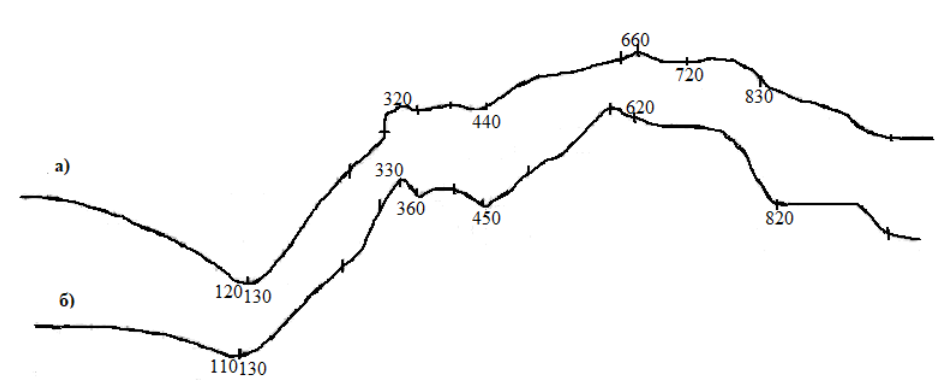
Fig. 7. Derivation of soil-concrete consistencies : a) experimental and b) control soil- concrete samples (DThA) (consistence 2) . To study the effect of heat treatment using solar energy on the hardening of soil concretes on the basis of oil - contaminated soil, cement, and sand , 2 series of consistence using concrete additives have been formed. Under the code 22, samples were formed, hardening in natural conditions. Under the code 2, the consistence s subjected to heat treatment with the use of solar energy are indicated (Fig . 7). To study the effect of heat treatment with the use of solar energy in the mineralogical consistence of the soil - concrete were moulded for samples consisting of sludge, cement, and sand. The control sample under code 44 hardened in vivo, as an experimental model under code 4 is heat treated using solar energy. According to the thermal analysis results can be seen that the DThA – endoeffect curve ( – ) 100 ° С removal of free water. Exoeffects (+) and 320 (+) 410 °C burning hydrocarbon components of the sludge. Exoeffects (+) 2 20 ° С – consistence of hydrocarbons and methane series (+) 320 ° С – waxy structure of the organic components of sludge. Endoeffect ( – ) 480 °C, associated with the expansion of portlandite intensity. It also points to the beneficial effects of heat treatmen t with the use of solar energy in the soil - concrete hardening.